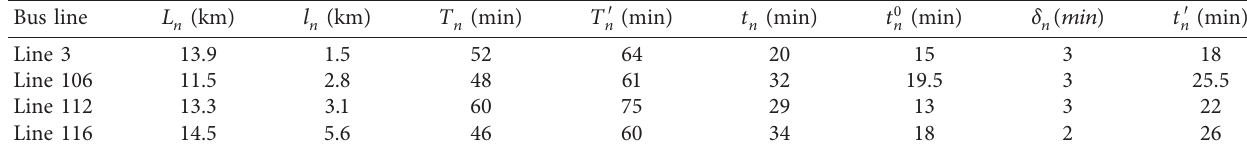
Table 2: Operational parameters of the four bus lines.